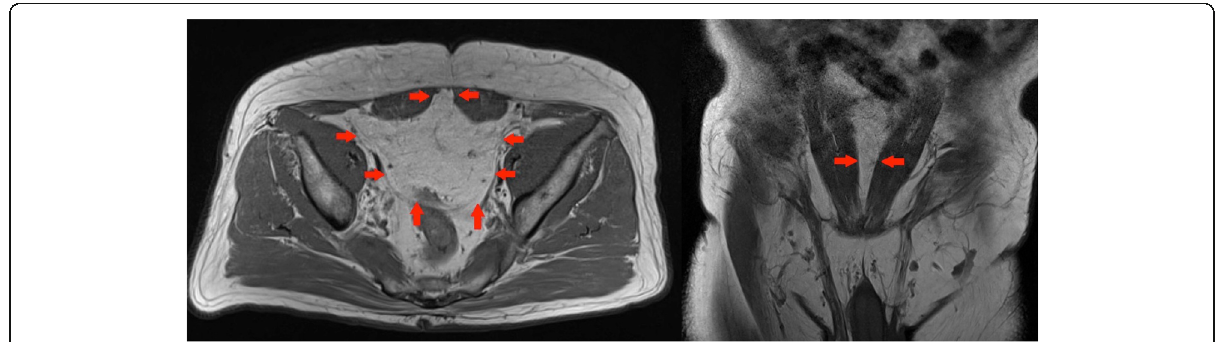
Fig. 7 Left panel: Axial T1-weighted MRI of the pelvis and lower abdomen: red arrows outline the intra-abdominal lipomatous lesion with high T1 signal. Anteriorly the lesion is seen to split the recti in keeping with divarication. Right panel: Coronal T1-weighted MRI of the pelvis and lower abdomen: divarication of the recti (red arrows) secondary to a fat containing lesion in the